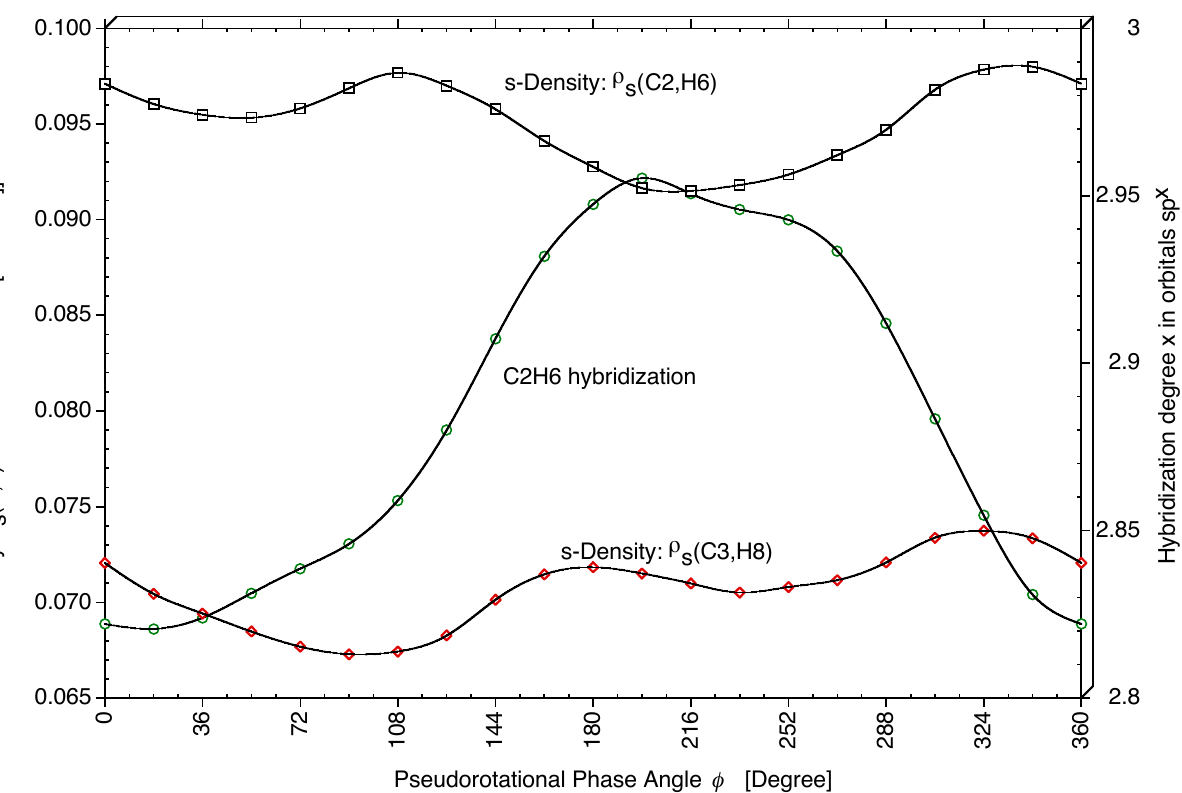
Figure 5: Dependence of the s -densities (cid:37) tational phase angle. The hybridization of the C2H6 bond orbital as calculated with the NBO approach is also given. B3LYP/6-31G(d,p)